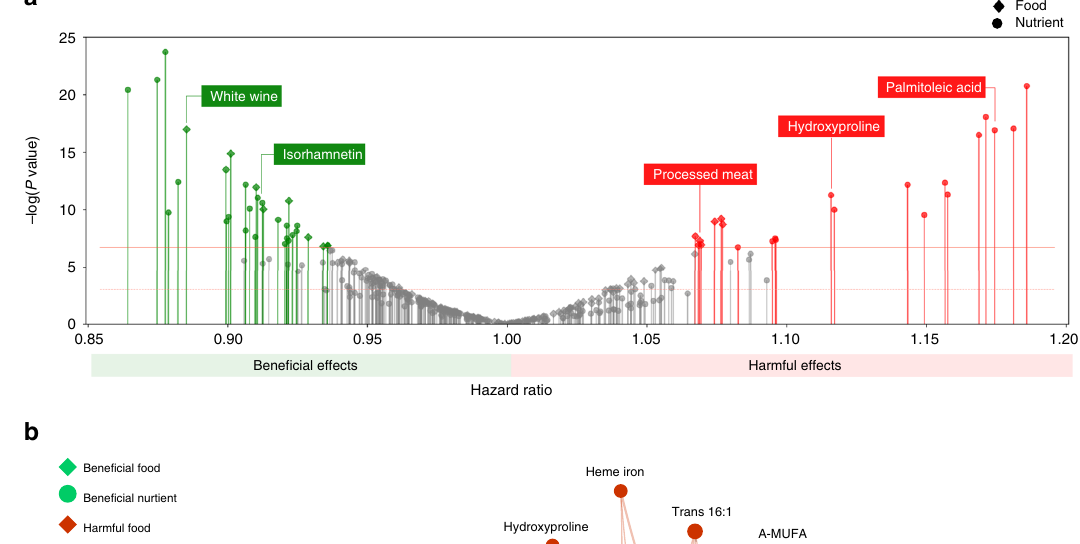
(Fig. 3a). Using a force-directed layout algorithm, we represent this information as a bipartite network, allowing us to explore the signi fi cant inter-dependencies among nutrients and food items. In Fig. 3b, negatively associated nutrients and foods are color coded as green and positively associated nutrients and foods are shown in red. We retrieve two clearly distinct clusters, negatively associated nutrients and foods on one hand, and positively associated nutrients and foods on the other. We also fi nd that several food items, such as white bread and yogurt are connected to both negatively and positively associated nutrients. As